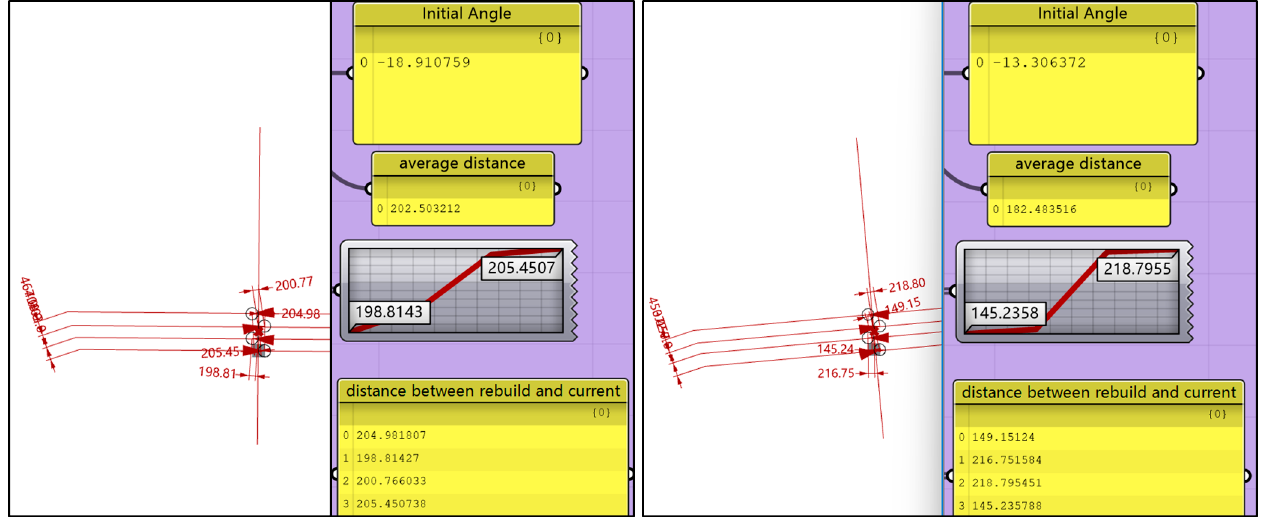
Figure 12. Verification of four columns (the disordered axes on the left, the result axes on the right).